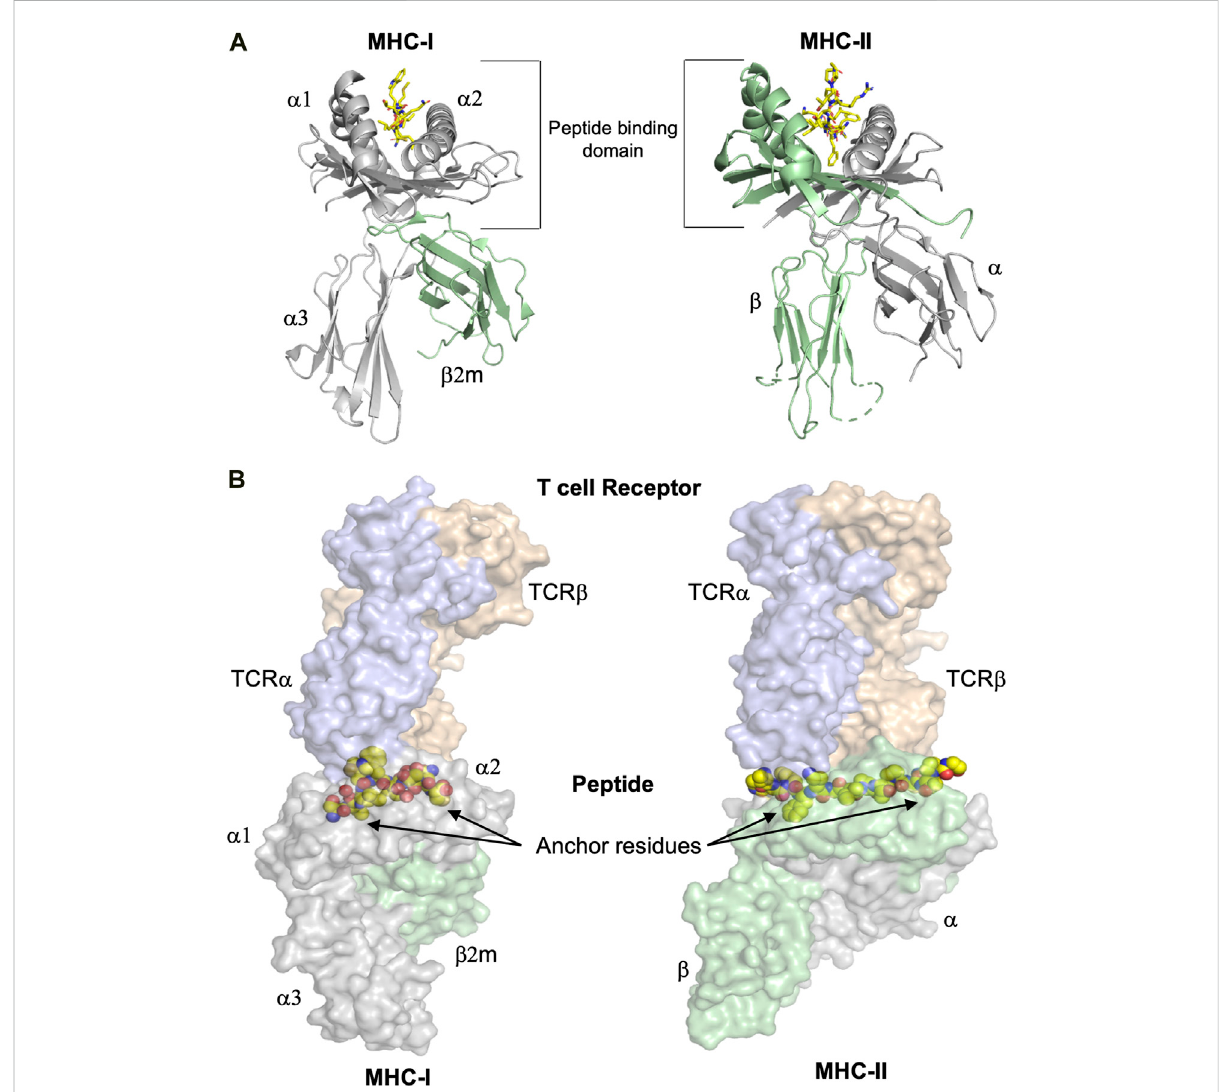
FIGURE 1 The overall structures of MHC-I and MHC-II complexes are similar. (A) Despite the similarity of their overall three dimensional folds, there are somesigni fi cantdifferencesbetweenMHC-IandMHC-IImolecules.Leftpanel:ThepolymorphicMHC-Iheavychain,coloredingrey,comprisesthe peptide binding domain (PBD or α 1- α 2 domain) and an additional Ig-like domain denominated α 3. Furthermore, the almost invariable Ig-like β 2 - microglobulin ( β 2m) domain, colored in green, binds non-covalently between the α 1- α 2 and α 3 entities, stabilizing the overall structure of MHC-I/peptide complexes (pMHC). The peptide is colored in yellow. Right panel: MHC-II molecules consist of the two polymorphic α and β chains (ingreyandgreen,respectively),eachonecomprisinghalfofthePBDandeachonewithanadditionalIgdomainthatseparatesthePBDfromthecell membrane. The peptide is colored in yellow. (B) T cell receptors bind on the top of pMHC molecules, interacting with both the presented peptides and the MHC chains. The surfaces of both TCR and pMHC are semitransparent. Left panel: The α and β chains of the MHC-I-restricted TCR are colored light blue and orange, respectively, while the surfaces of the heavy chain and β 2 m are in light violet and light green, respectively. The side chains of the presented peptide are represented by yellow spheres. Nitrogen and oxygen atoms are in blue and red, respectively. Classical examples of canonical peptide anchor residues are indicated by arrows, with their side chains buried within speci fi c MHC pockets. The N- and C-termini of MHC-I peptide-binding clefts are closed, restricting most often the length of the bound peptides to 8 – 10 amino acids. Right panel: The α and β chains of the MHC-II-restricted TCR are in light blue and orange, respectively. The three dimensional structures of the ternary complexes derveal that MHC-II-restricted TCRs mostoftenbind very similarly to their cognate pMHC-II complexescompared to MHC-I-restrictedTCRs. Incontrastto amajorityofMHC-I-restrictedpeptides,the fl ankingresiduesofmostMHC-II-restrictedepitopesareprotrudingourfromboththeN-andC-termini of the MHC-II cleft and are more solvent accessible. All fi gures were created using PyMOL (The PyMOL Molecular Graphics System, Version 2.3.0, Schrödinger, LLC). All fi gures were created using the TCR/pMHC ternary structures determined in 2BNR.pdb and